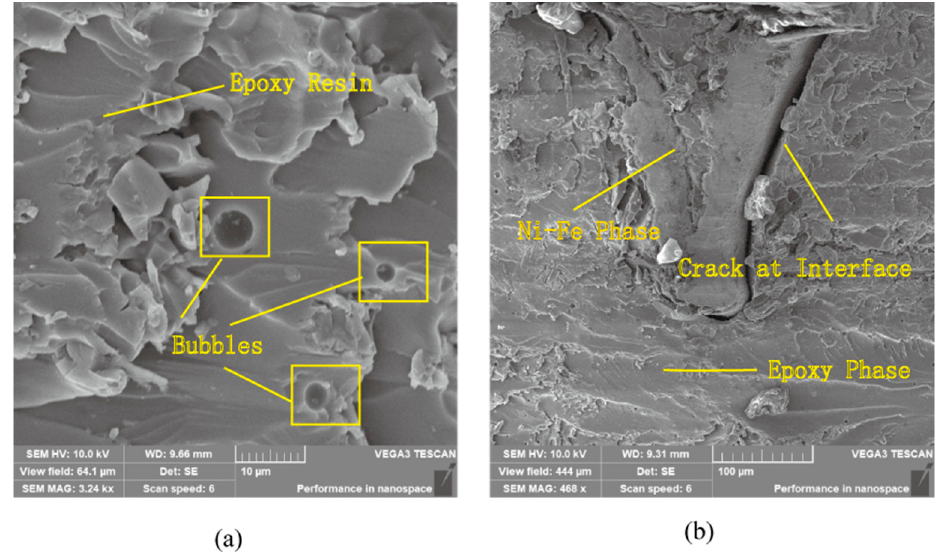
Figure 4. Microscopic defect diagram of Ni-Fe/Epoxy IPC tensile morphology ( a ) initial defect ( b ) process damage.